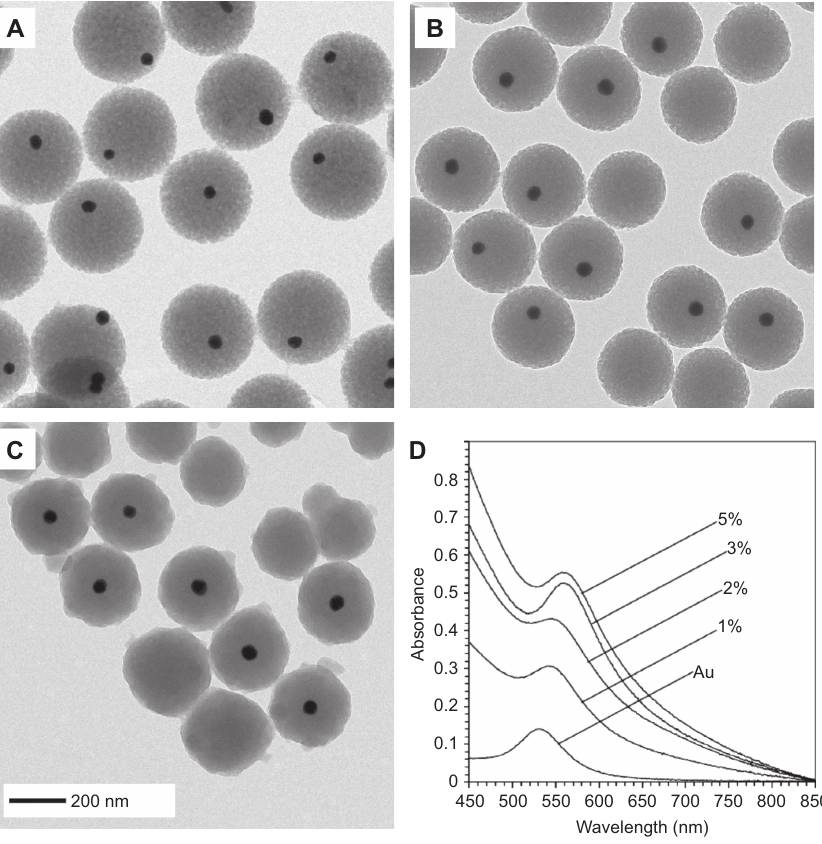
Figure 4 TEM images of Au-polystyrene (PS) hybrid particles. This image shows that the position of the Au nanoparticle can be altered by a variation of the concentration ratio between PS and divi- nylbenzene (DVB). The corresponding quota of DVB is (A) 2%, (B) 3%, and (C) 5% by weight. In the optical absorption spectra, a red shift of the gold plasmon resonance wavelength occurred at increasing DVB concentrations. Reprinted with permission [71]. Copyright © 2009, American Chemical